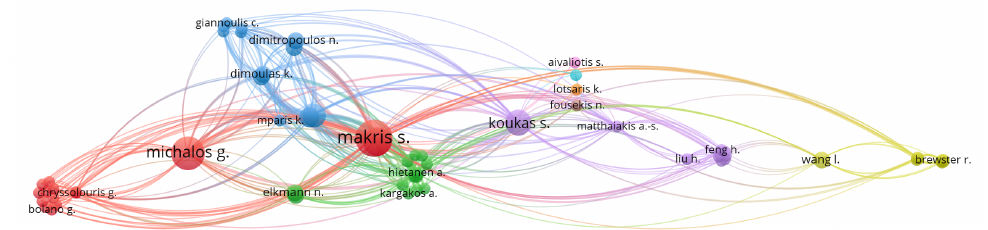
Figure 9. Author citation correlation between the selected papers.